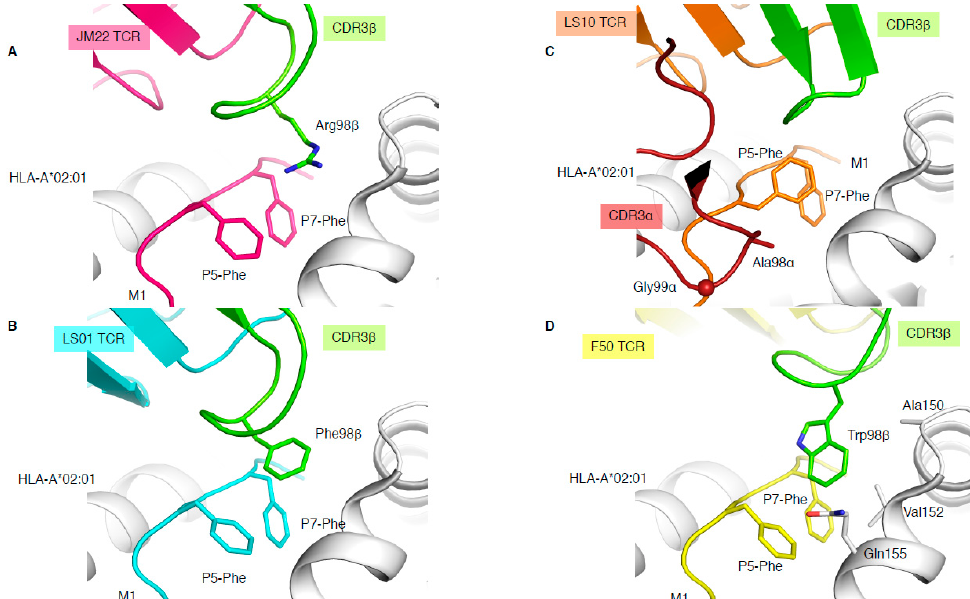
Figure 4. Different solutions to engage with the same pMHC-I complex . Structures of HLA-A*02:01 (white) presenting the M1 peptide in complex with the JM22 TCR ( A ), LS01 TCR ( B ), LS10 TCR ( C ), or F50 TCR ( D ). The structures were superimposed by aligning the cleft (residues 1–180) and presented in the same orientation. The M1 peptide is coloured as per the bound TCR in pink with JM22 ( A ), cyan with LS01 ( B ), orange with LS10 ( C ), and yellow with F50 ( D ), and the P5-Phe and P7-Phe are represented as sticks. The CDR3 β loop is coloured in green for all TCRs, and the CDR3 α is removed from all panels but ( C ), where its coloured in red. The sphere on panel ( C ) represents the C α atom of the F50 TCR Gly99 α .